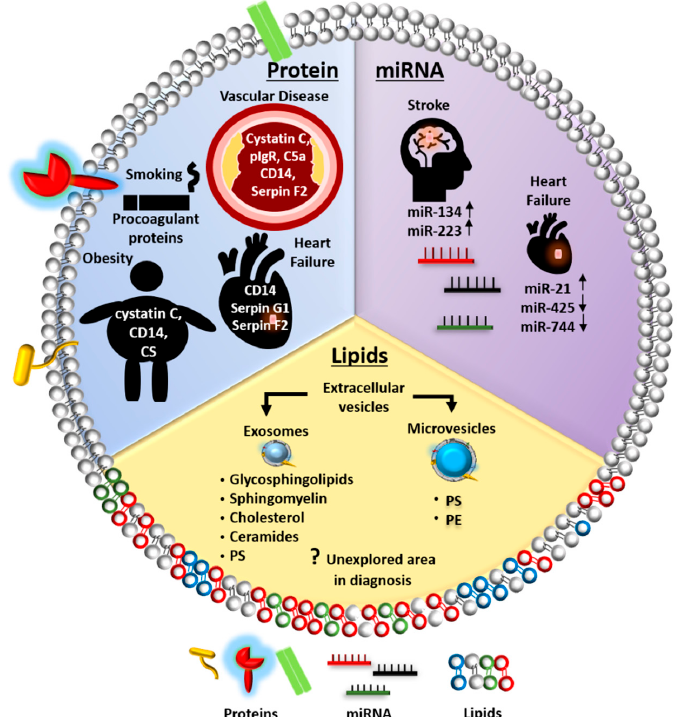
Figure 1. Schematic diagram illustrating EVs as an alternative source of biomarkers in cardiovascular disease (CVD). Extracellular vesicle (EV) proteins, such as CD14, cystatin C and coagulation-related proteins including Serpin G1 and Serpin F2, have been proposed as novel biomarkers for diagnosis and prognosis of heart failure, vascular disease, and stroke. Conventional CVD risk factors, such as obesity and smoking, have been associated with EV protein contents, including CD14, cystatin C, and procoagulant proteins. Certain EV miRNAs have also been identified as novel diagnostic and prognostic biomarkers for stroke and heart failure. Five EV miRNAs are listed as representatives. EV lipids, however, remain largely unexplored in the diagnosis or prognosis of CVD. CVD, cardiovascular diseases; CS, complement system; C5a, complement factor 5a; pIgR, polygenic immunoglobulin receptor; PS, phosphatidylserine; PE,